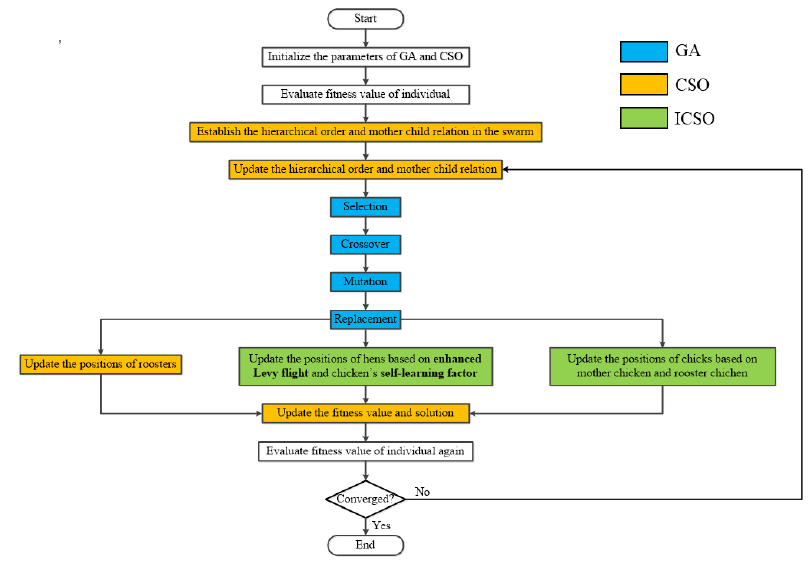
Figure 9. The flowchart of GA-ICSO.